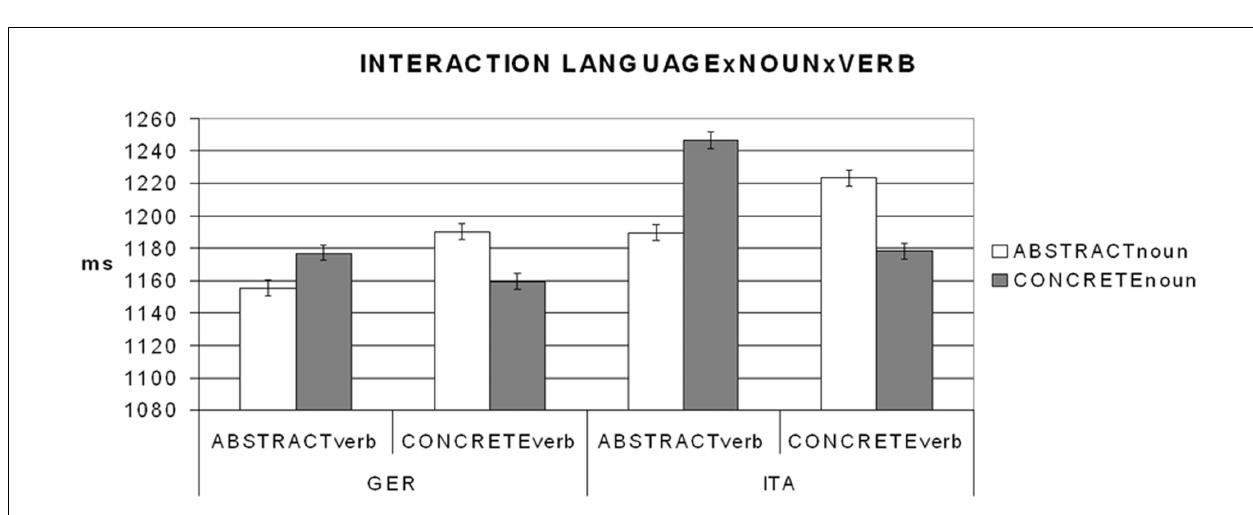
FIGURE 5 |The interaction among the kind of Language, the kind of Noun, and the kind ofVerb, p < 0.03. German participants were faster with Abstract Verb plus Concrete Noun, than with ConcreteVerb plus Abstract Noun. The pattern of the Italian participants was opposite.